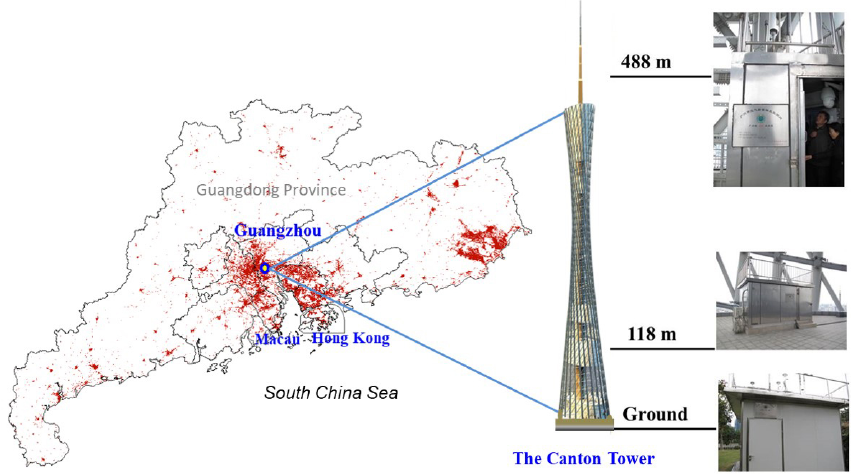
Figure 1. Map showing the PRD region and the Canton Tower sampling sites in Guangdong Province, China. The red contour indicates the spatial distribution of urban areas from ESA’s global land cover data 2015 (credit: http://www.esa-landcover-cci.org/, 17 May 2019).